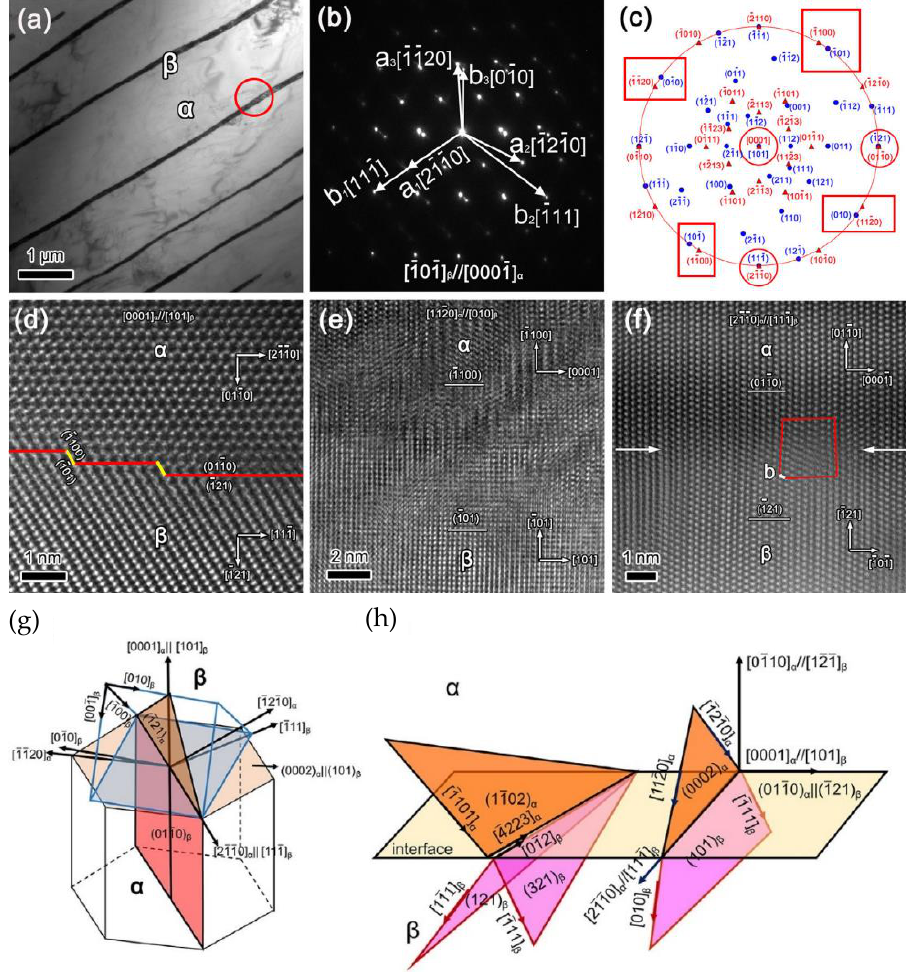
Figure 10. ( a – f ) The crystallographic characteristics and orientation relationship of the α/β phase boundary of the lamellar structure; ( g , h ) a 3D orientation relationship schematic image and the geometric relationships among slip systems of α and β [97].